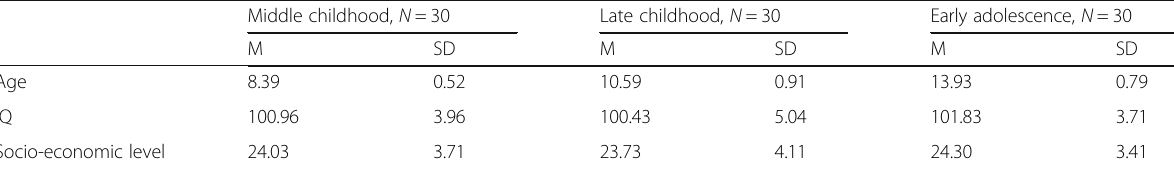
Table 2 The characteristics of the participants with normal reading